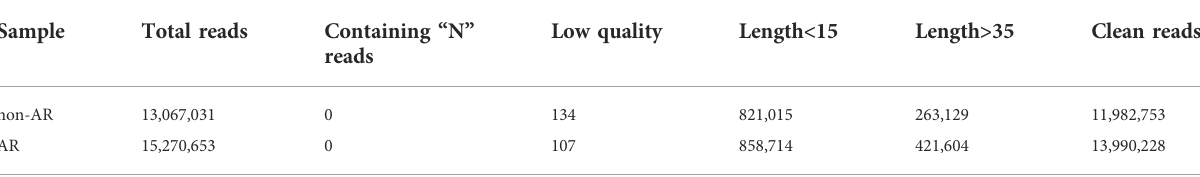
TABLE 1 Raw data quality